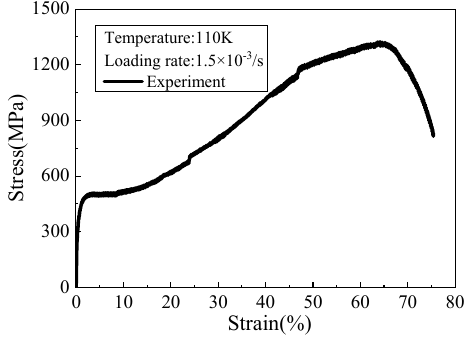
Figure 2. Uniaxial tension curve.